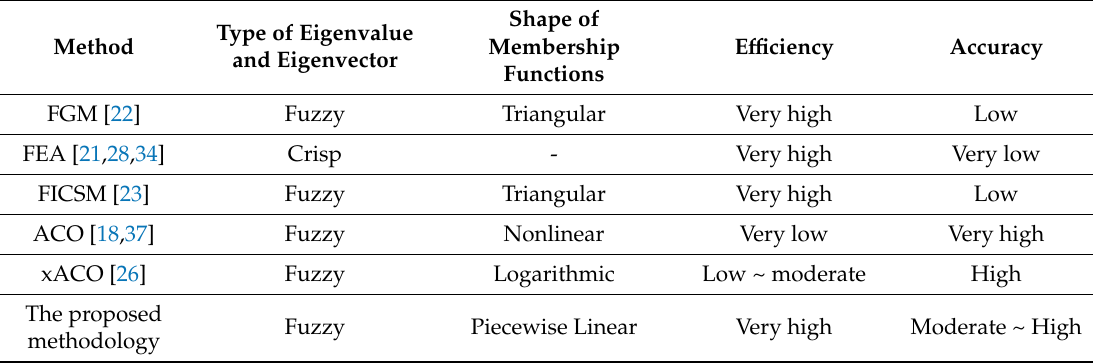
Table 1. Di ff erences between the proposed methodology and some existing methods.